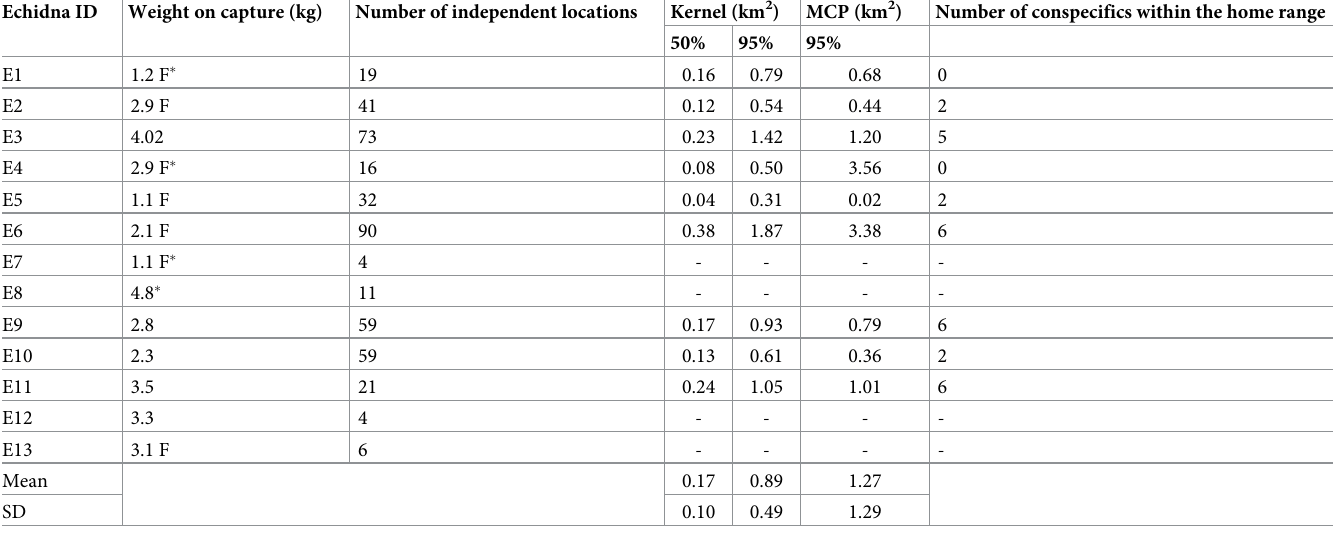
Table 1. Home ranges of echidnas determined by three different calculation methods: 95% kernels (peripheral area), 50% kernels (core area) and 95% minimum convex polygons (MCP). Echidna ID Weight on capture (kg) Number of independent locations Kernel (km 2